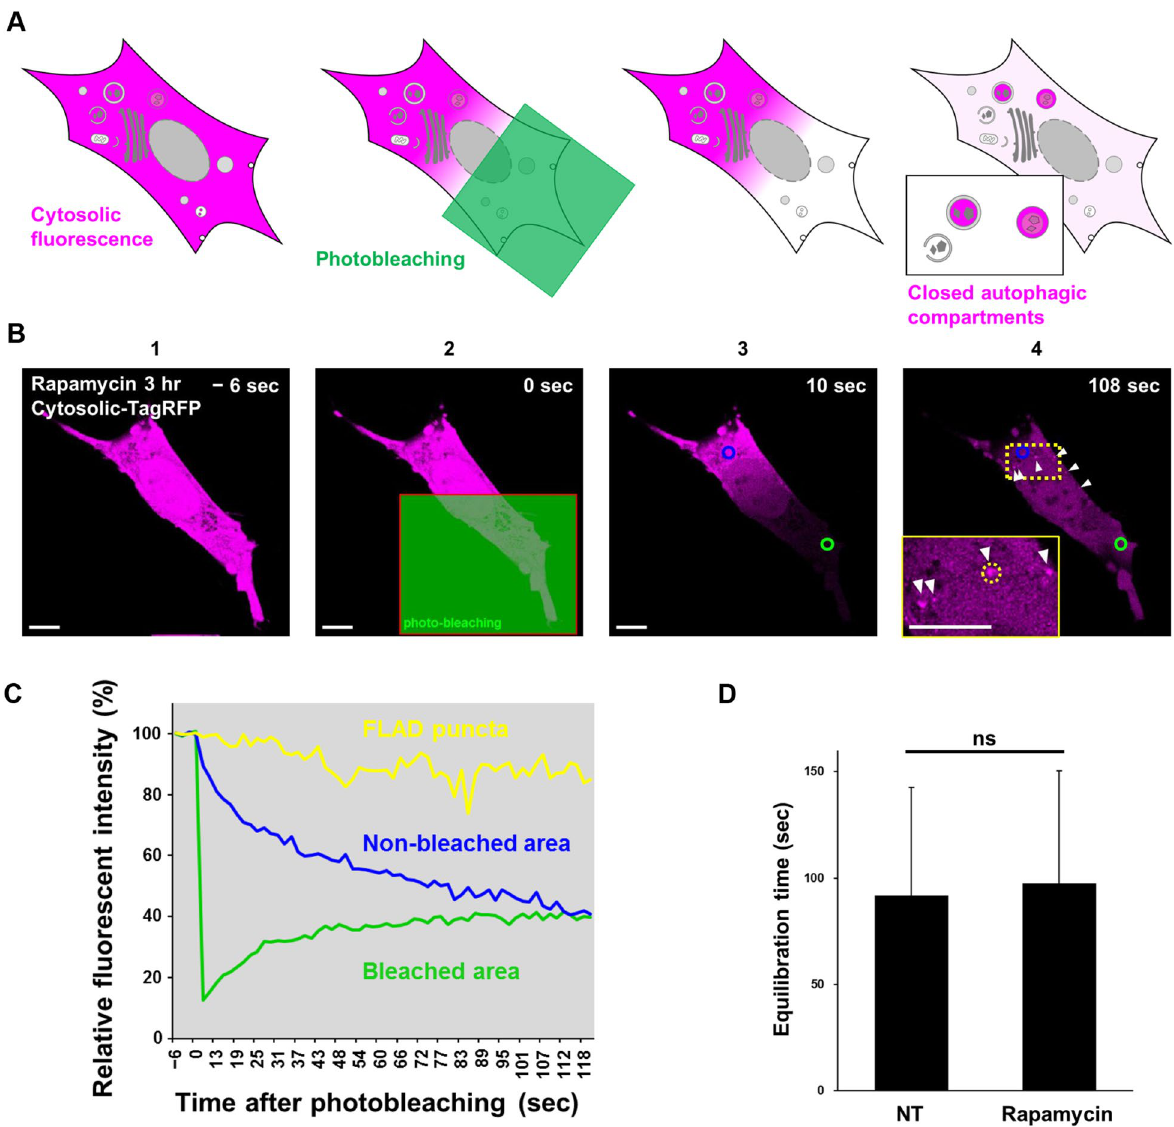
rapamycin for 3 h to induce canonical autophagy. Then, the FLAD assay was performed. Image 1: just before photobleaching. Image 2: during photobleaching. Half of the cell area in the confocal plane (green rectangle) was photobleached. Image 3: just after photobleaching. Green and blue circle: region used to measure fluorescence intensity of the bleached area and non-bleached area, respectively. The TagRFP fluorescence disappeared only in the bleached area. Image 4: 108 s after photobleaching. Several FLAD + puncta were observed as bright TagRFP puncta (arrowheads) in the non-bleached area. The ROI is shown by the yellow dotted rectangle and the magnified image is shown in the inset. Bars = 10 µ m. (C) Time-dependent alterations in fluorescence intensity in the bleached area (green circle in image 3 of B), the non-bleached area (blue circle in image 3 of B), and FLAD + puncta (yellow dotted circle in image 4 of B) was monitored continuously. Note that the blue and green circles are almost an equal distance from the borderline of the bleached area. (D) Equilibration time of wild-type MEFs treated with or without rapamycin (0.5 µM). Cytoplasmic intensities were equilibrated at 91.1 ± 50.6 s in control cells (n = 5) and 97.4 ± 53.1 s in cells treated with rapamycin for 3 h (n = 4). Error bars indicate the S.D. Statistical analysis was performed by the Student t -test. ns: no significant